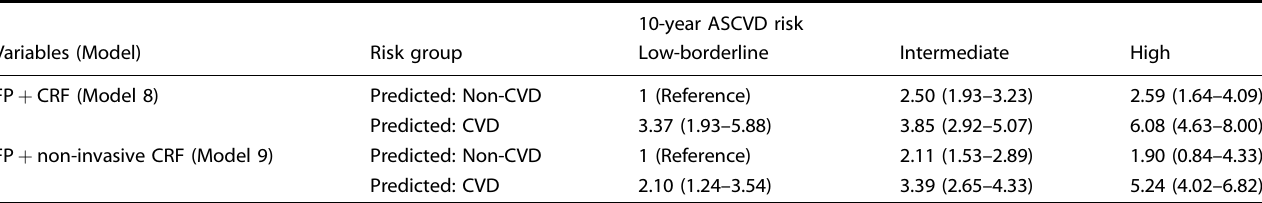
Table 3. Hazard ratios (95% CI) for future CVD events of subgroups by the multimodal network (Models 8 – 9) and 10-year ASCVD risk with at-risk patients in the UK Biobank.